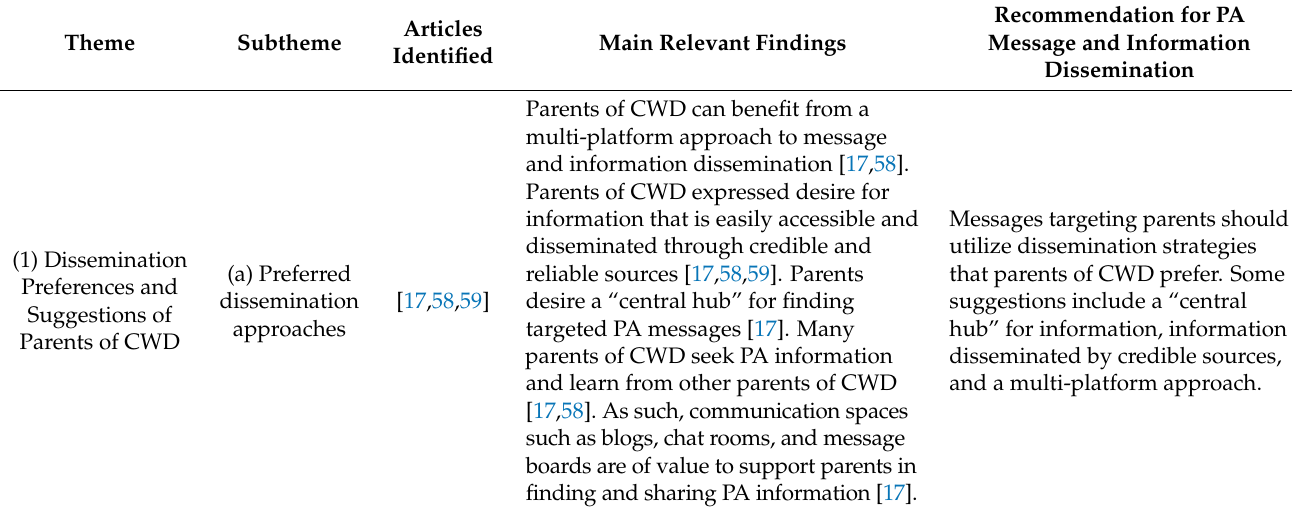
Table 5. Literature regarding the dissemination of physical activity messages targeting parents of children with